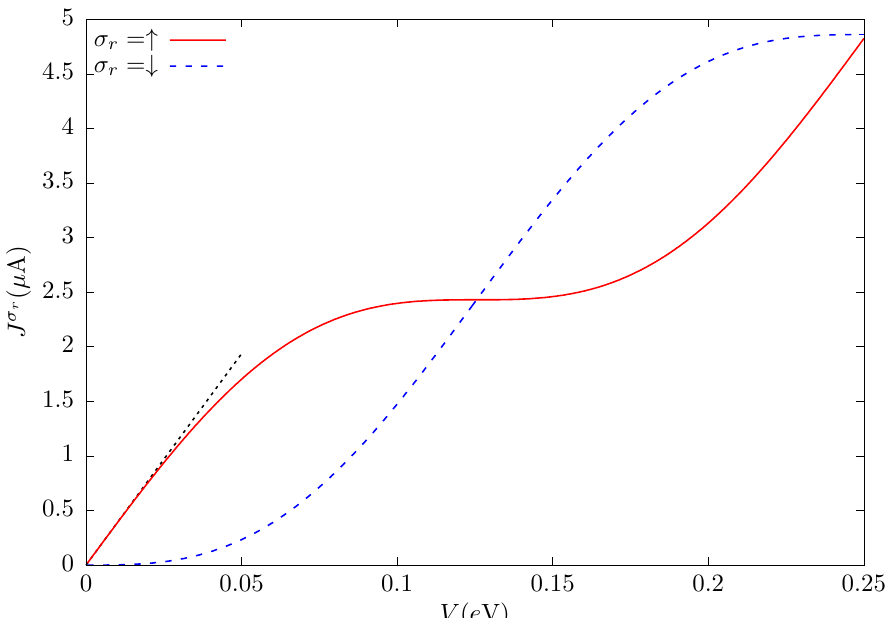
Figure 5. Electronic current J σ r injected into the metallic conductor as a function of the applied potential V . As in Figure 4, the distance between contacts is R = 100 a and the Rashba and Dresselhaus SOC parameters are α = 1.212 10 − 2 t and β = 10 − 2 t , respectively. The Fermi level is taken to be × (cid:101) F = 9.422 10 − 2 t , value for which the spin-down conductance is zero, and t = 1 e V. The black × dotted line corresponds to the slope e / h